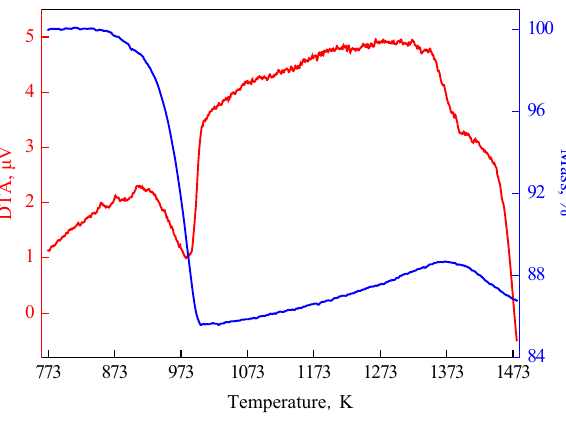
Figure 8: DTA - TG curves of samples after ashing at 873 K.